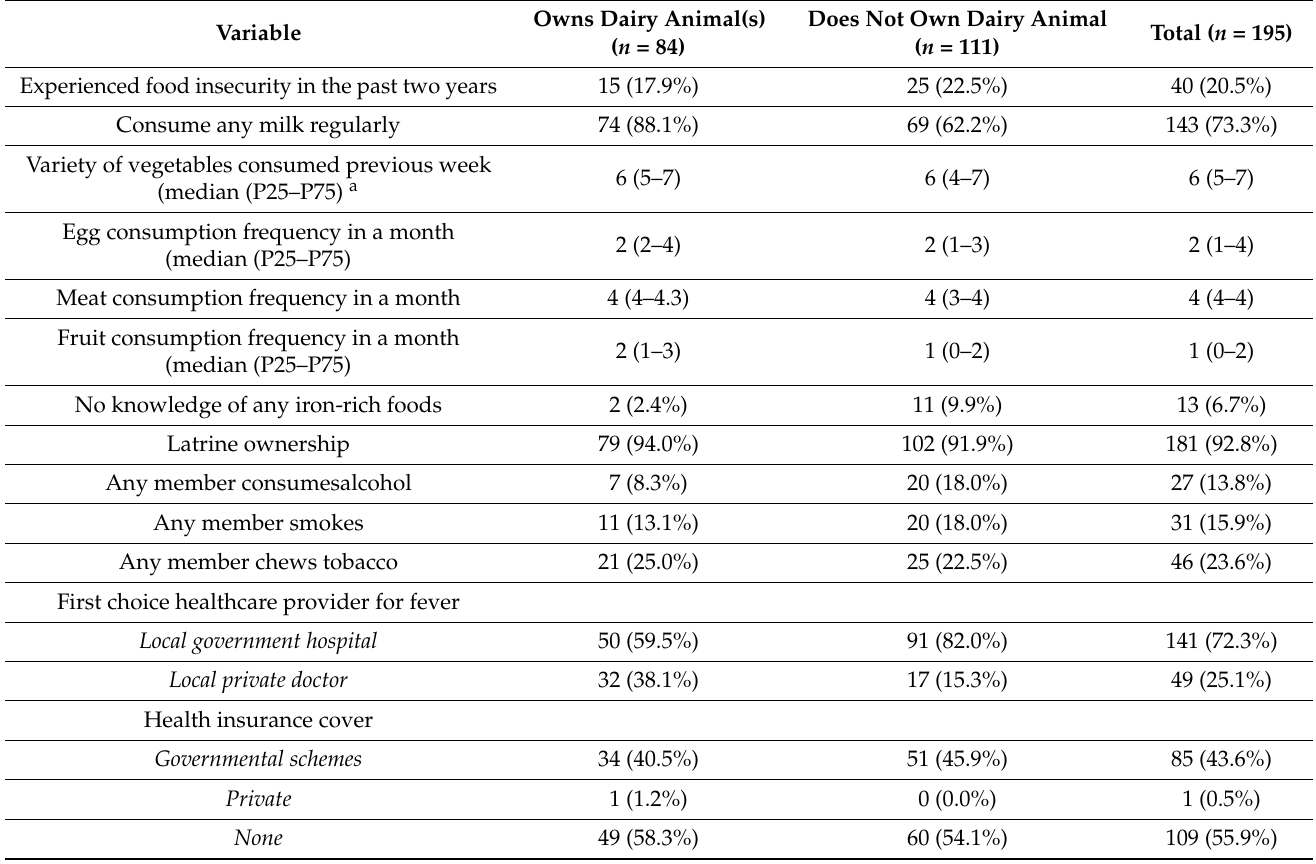
Table 2. Select health determinants in the study population based on a survey conducted between April and July 2019 in four villages in Kolar district, India.